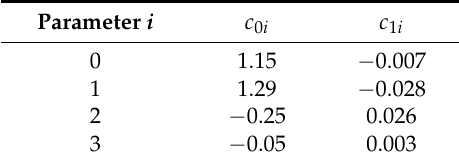
Figure 2 graphs the expected number of showers per occupant per day determined by Equation (3). Averages (i.e., T sf = 0 °C) from a previous study are also shown for comparison. The figure shows that there is approximately a 1% reduction in the number of showers per day for each 1 °C increment in T sf .